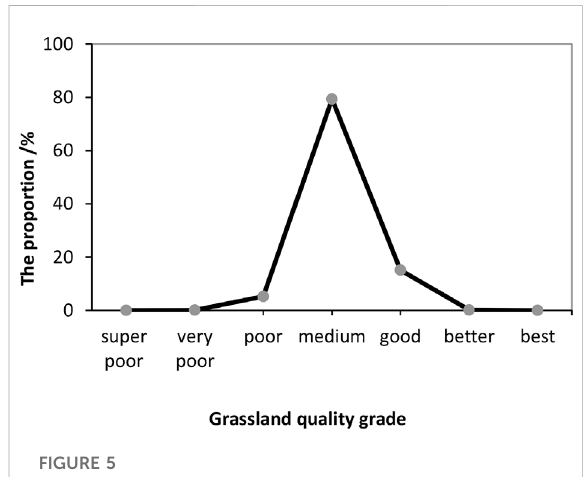
FIGURE 5 Classi fi cation statistics of the grassland quality index.